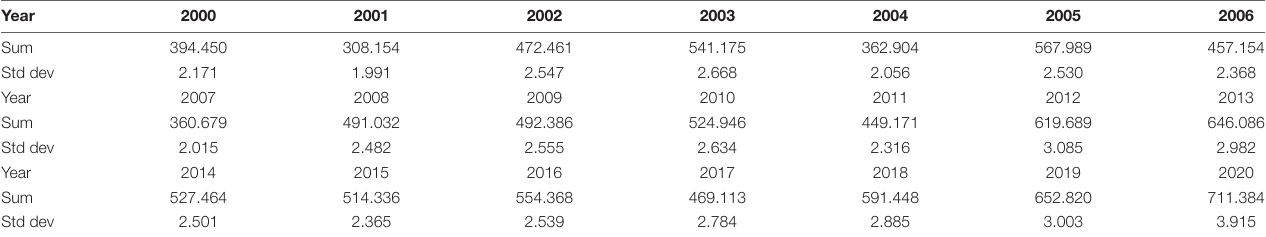
TABLE A2 | Statistics of annual precipitation on the Songnen Plain.